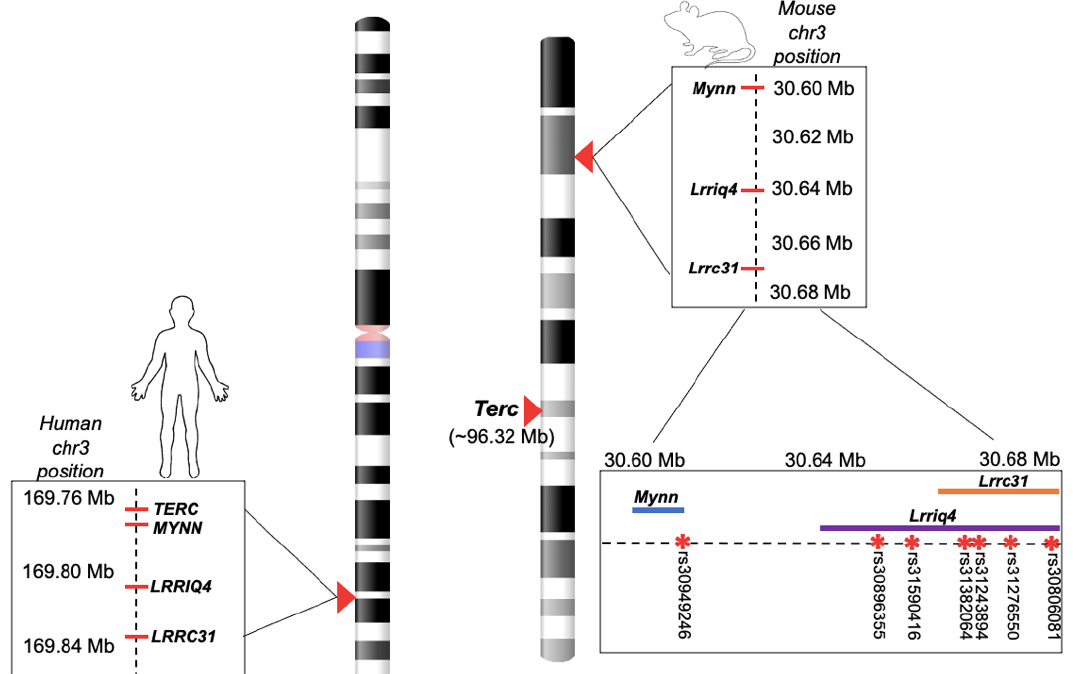
Figure 1. TERC / Terc gene and TERC / Terc gene cluster ( Lrrc31 , Lrriq4 , Mynn ) in human ( left ) and mouse ( right ) chromosome 3. Candidate SNPs for telomere length within mouse Terc gene cluster marked on expanded chromosome 3 view ( bottom right ).